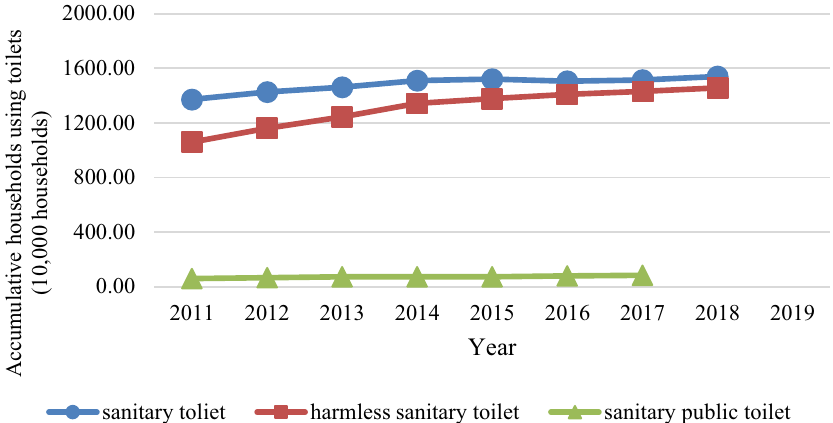
Figure 4. Trends in the cumulative households using three types of sanitary toilets (Unit = 10,000 households).